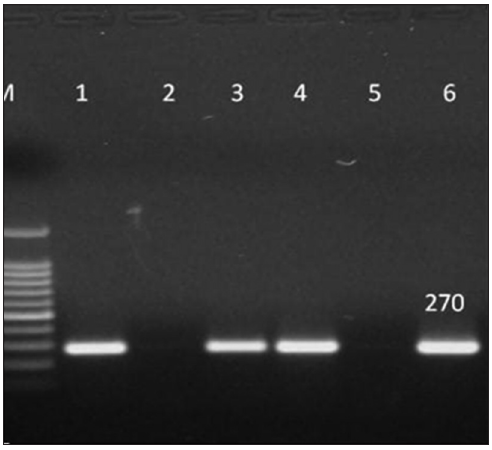
Figure-3: Polymerase chain reaction amplification of species-specific thermonuclease gene ( nuc ) of presumptive Staphylococcus aureus isolates. Lane M: 100 bp ladder, Lane 1: Positive control of S. aureus , Lane 2: Negative control having distilled water as template, Lane 3, 4, 6: Isolate from mastitic milk samples positive for S. aureus indicated by 270 bp band, Lane 5: Isolate from mastitic milk samples negative for S. aureus .